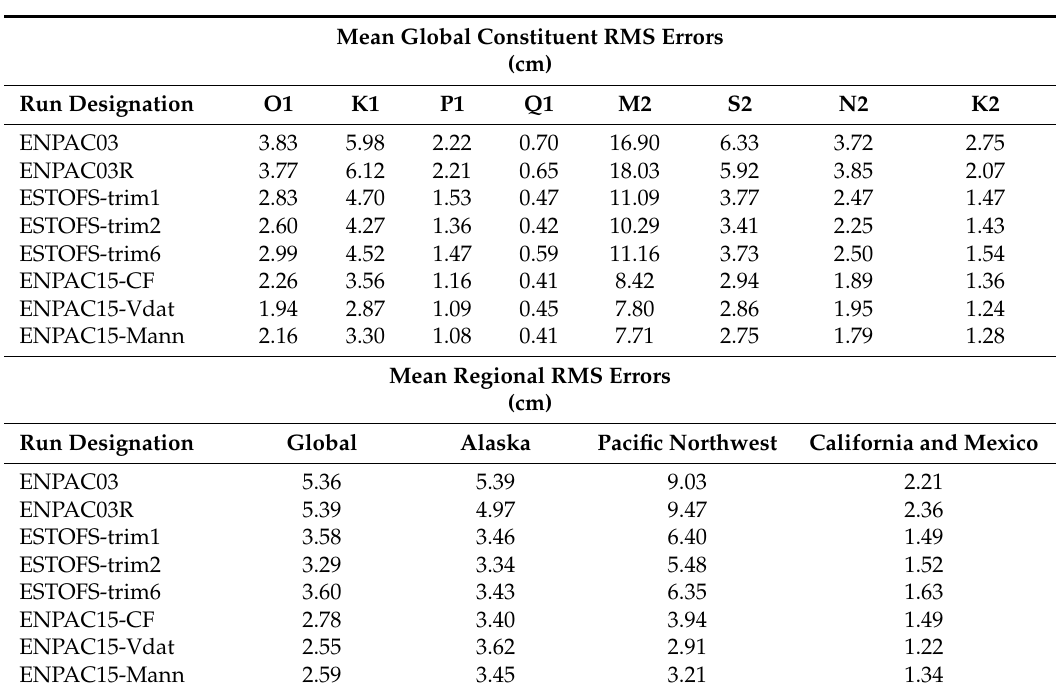
Table 8. Summary of RMS errors (cm) for the 165 common validation stations: global means for the 8 primary constituents and regional means summed over all eight primary harmonic